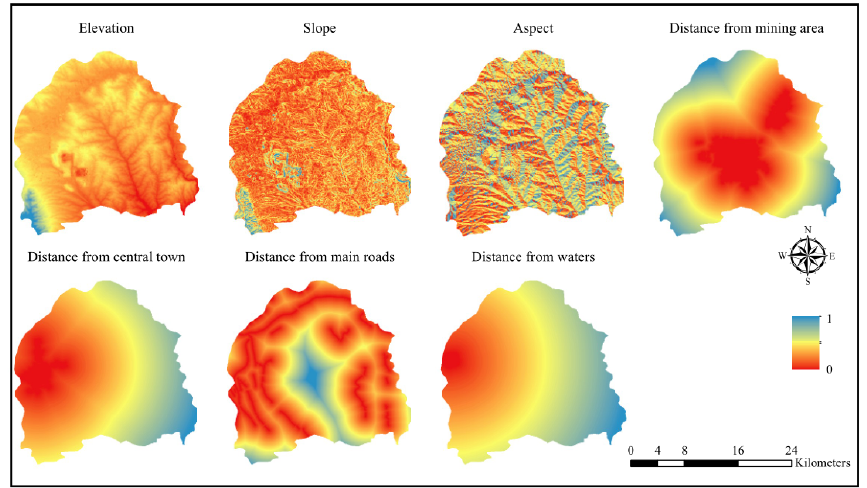
Figure 4. Limiting factor maps used for simulating land-use type